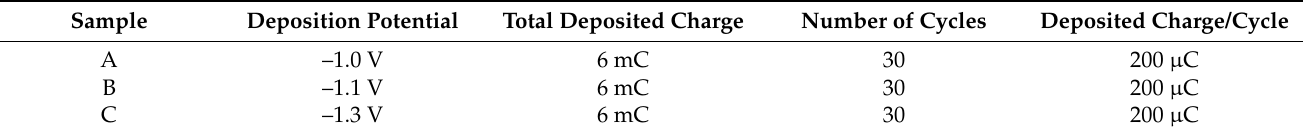
Table 1. Deposition parameters of samples A, B and C.